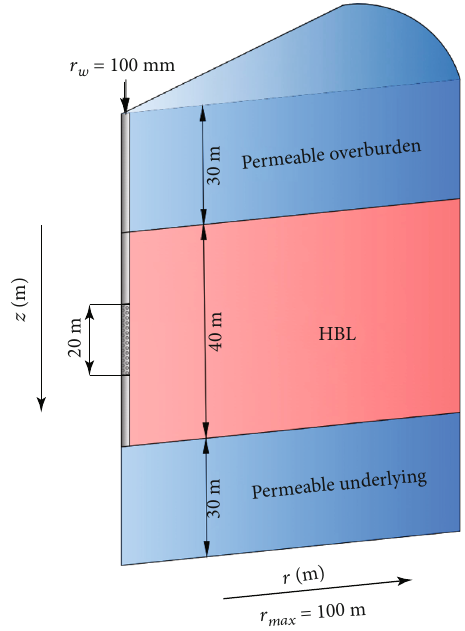
Figure 1: Schematic of the simulated NGH reservoir and well design in site